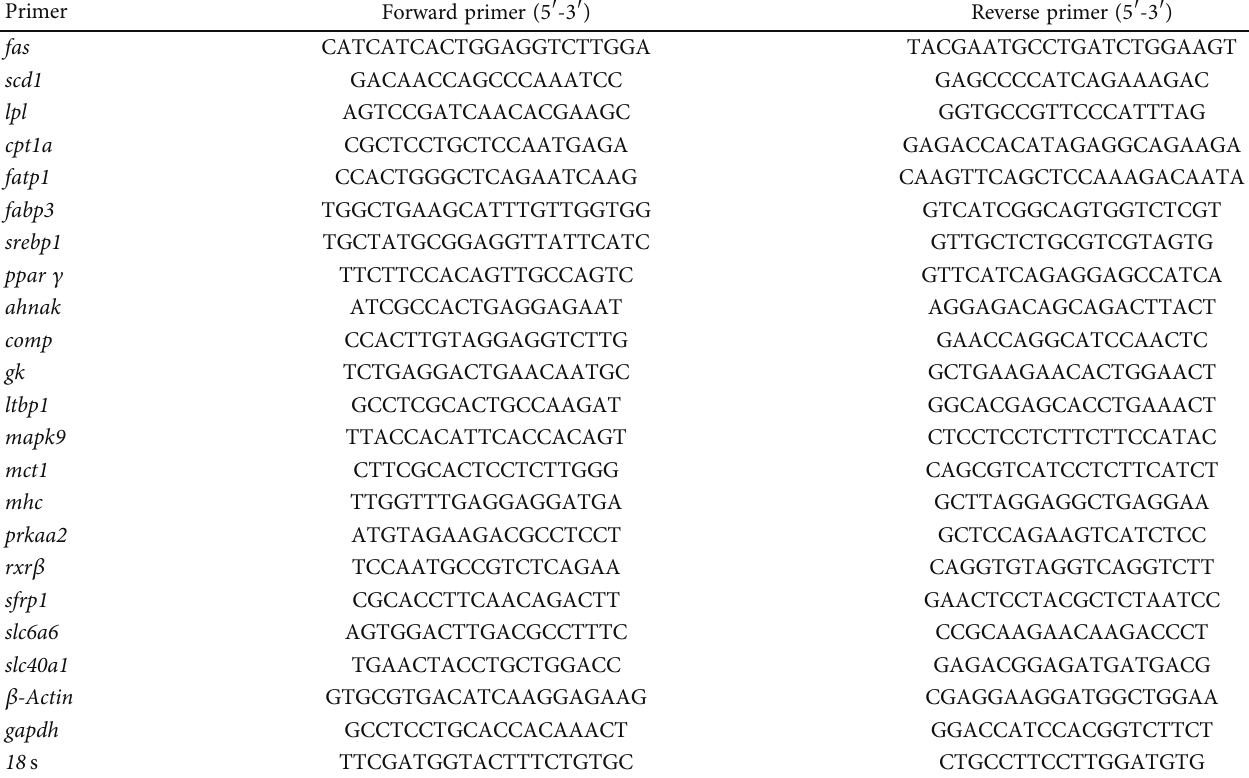
Table 1: qRT-PCR